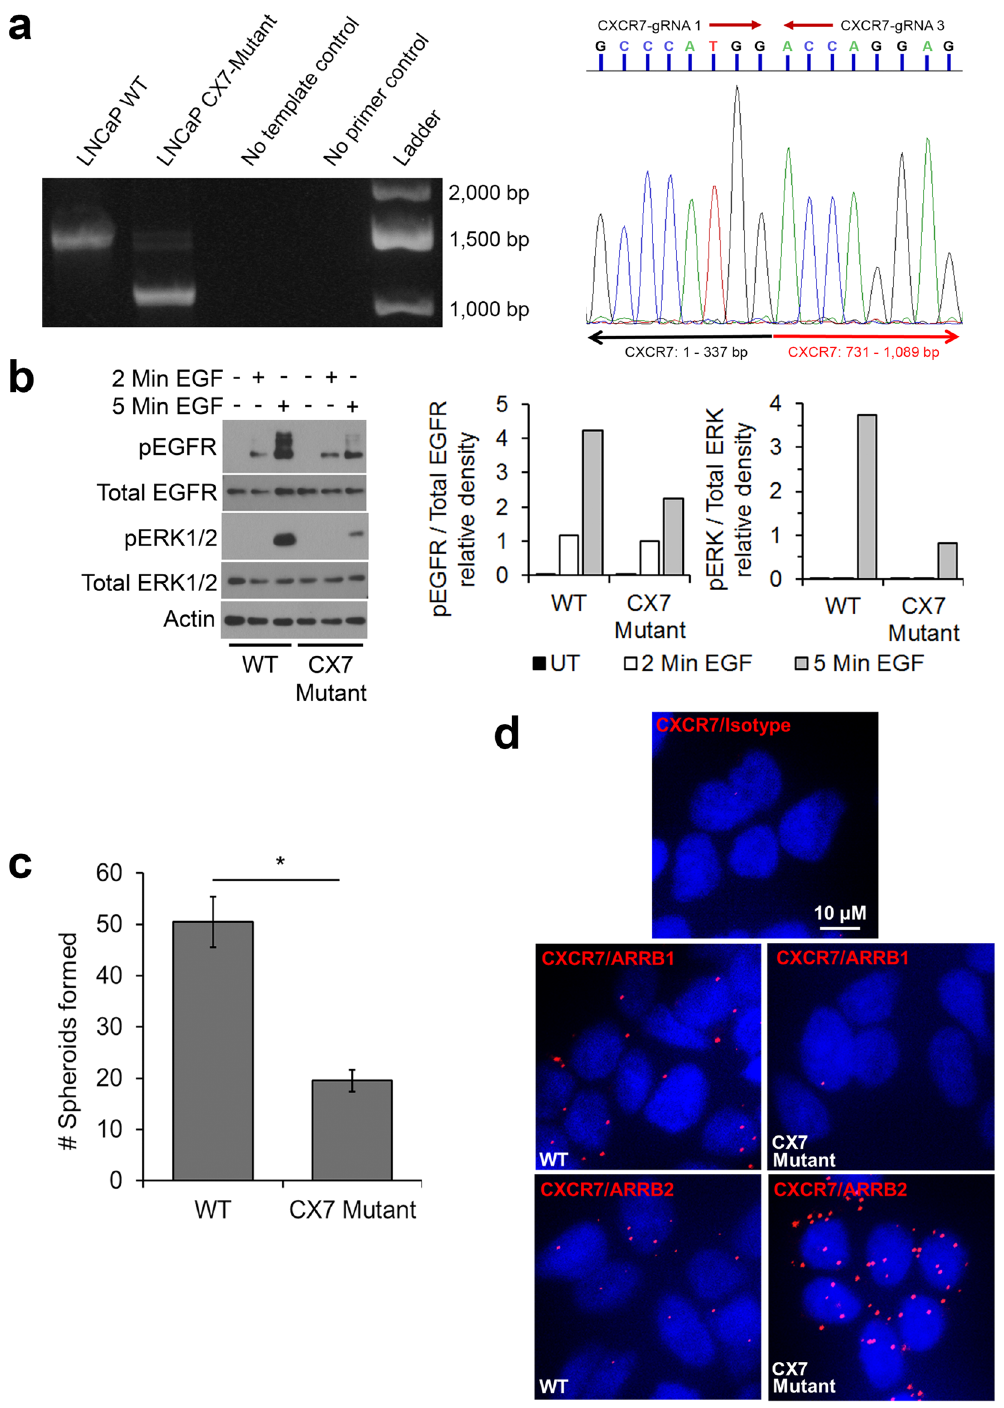
Figure 6. CRISPR-Cas9-generated CXCR7 inframe mutation in LNCaP cells disrupts membrane protein interactions. ( a ) Left: PCR of CXCR7 genomic DNA in unmodified cells (WT) and CRISPR-edited LNCaP cells revealing a 394 nt deletion event (CX7-mutant). Right: Sanger sequencing chromatogram of the DNA sequence illustrating the contiguous sequence, Black arrow represents the expected 5 ′ CXCR7 sequence and the red arrow shows the 3 ′ CXCR7 sequence around the site of deletion event. ( b ) EGFR and ERK phosphorylation in WT and CX7-mutant cells with densitometry of phosphorylated protein relative to total. ( c ) Count of second generation spheroids formed per plate from 10,000 seeded WT and CX7-mutant cells (n = 2, mean ± SD; * p < 0.05; unpaired, two-tailed Student’s t-test. ( d ) PLA staining for CXCR7 protein interaction with ARRB1, ARRB2, or isotype control in the WT and CX7-mutant cell lines. Nuclei are stained with DAPI (blue); red spots indicate that the two target proteins are co-localized within 40 nm of one another. The western blots are representative of three independent experiments with similar outcomes; densitometry is measured from the western blot panel